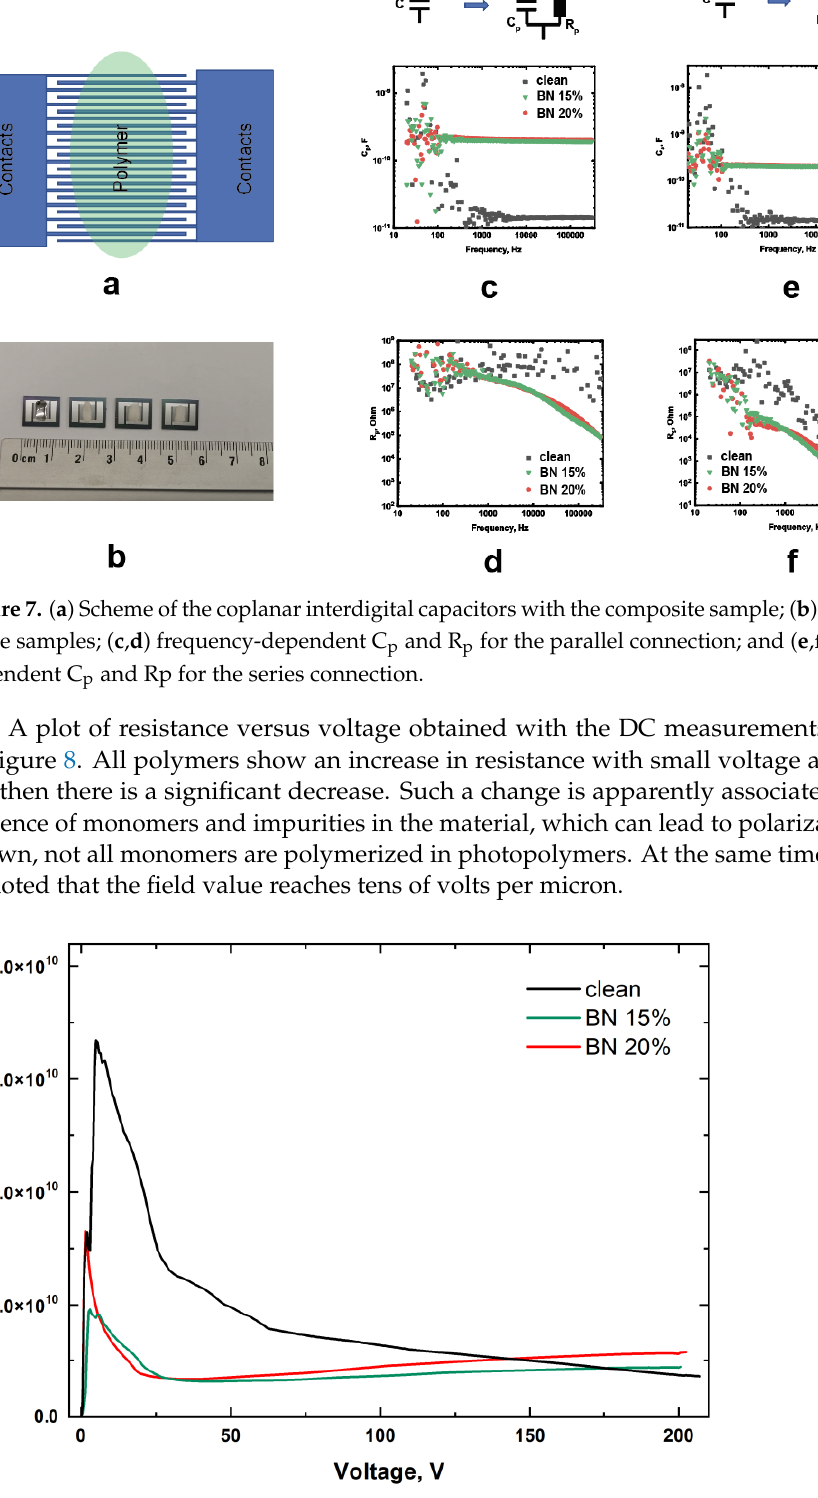
Figure 8. Resistance versus voltage obtained with the DC measurements.